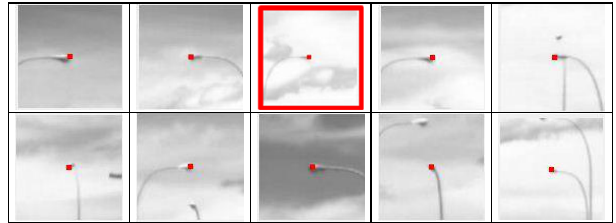
Figure 15. Matching results of type 4 dataset.